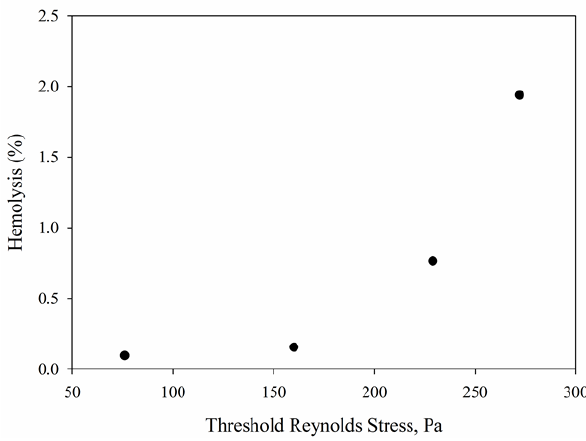
Figure 8. Relationship of hemolysis to threshold Reynolds stresses in capillary tube for all of the experiments (100 to 400 Pa).